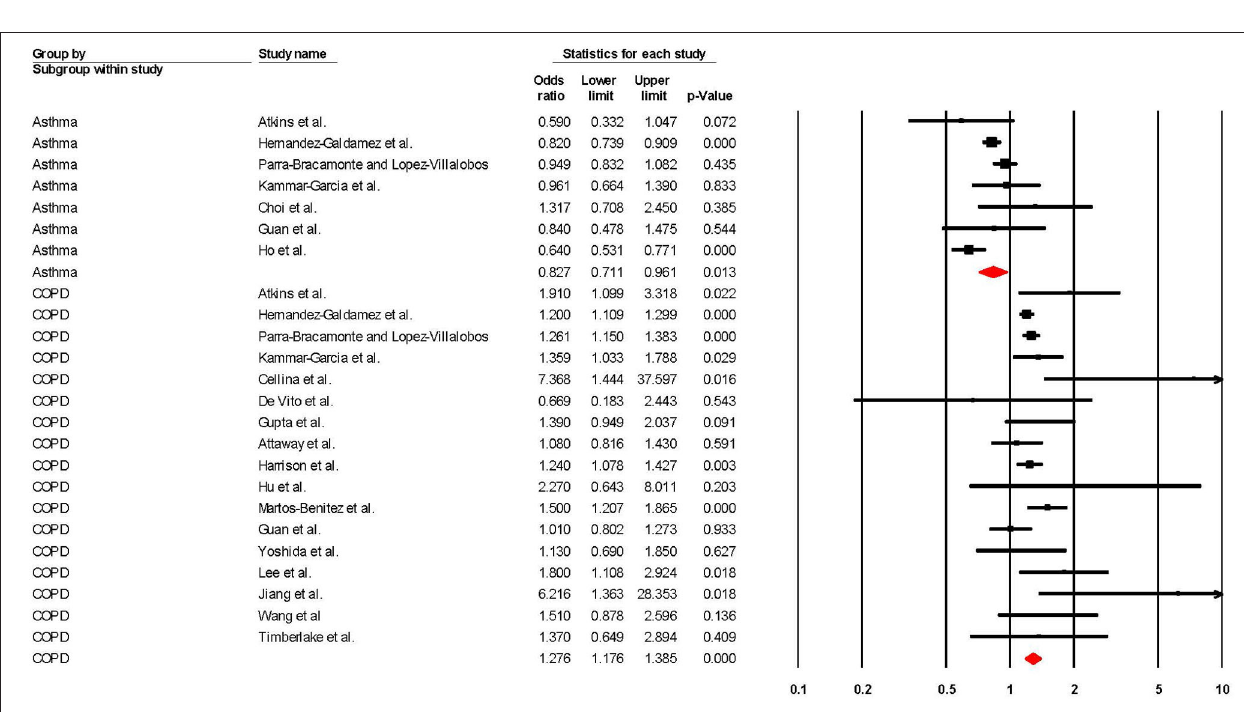
FIGURE 4 | Forest plot showing odds ratios (adjusted for at least one comorbidity) for COVID-19 related overall mortality in subjects with asthma or Chronic Obstructive Pulmonary Disease